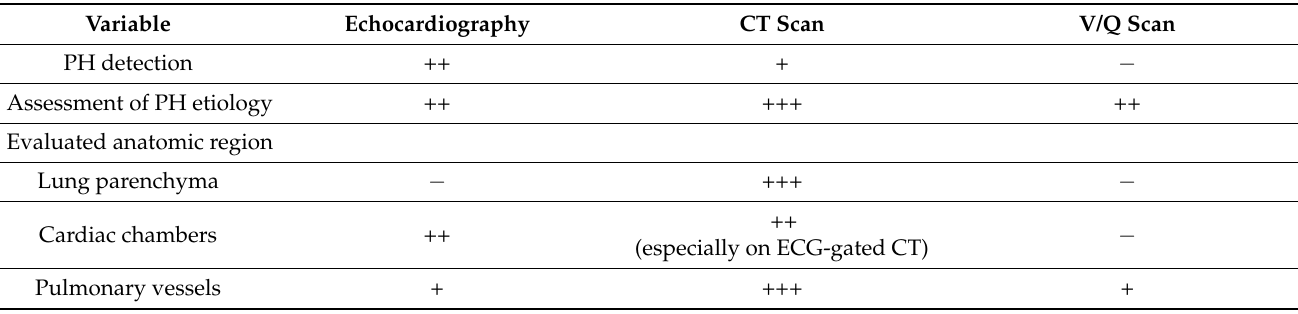
Table 1. Strengths and limitations of imaging